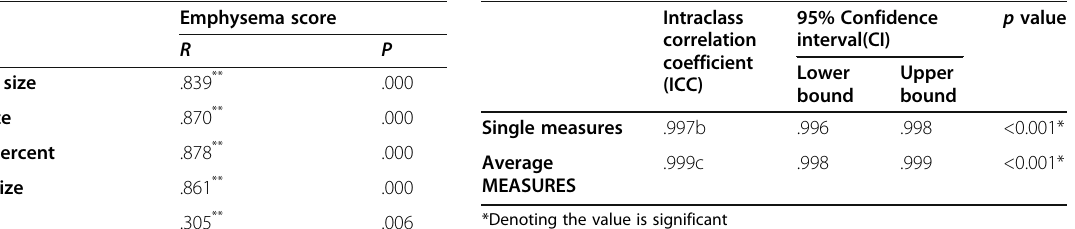
Table 4 Intraclass absolute agreement between two